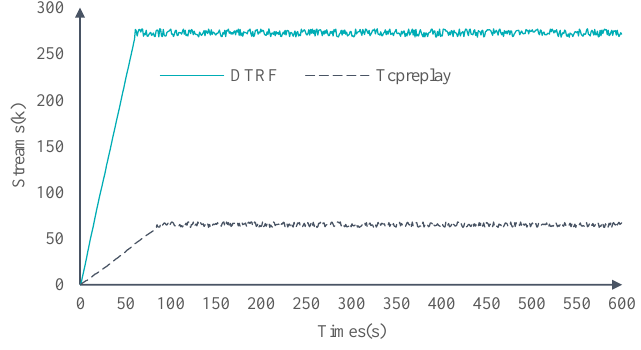
Figure 6. Throughput comparison.